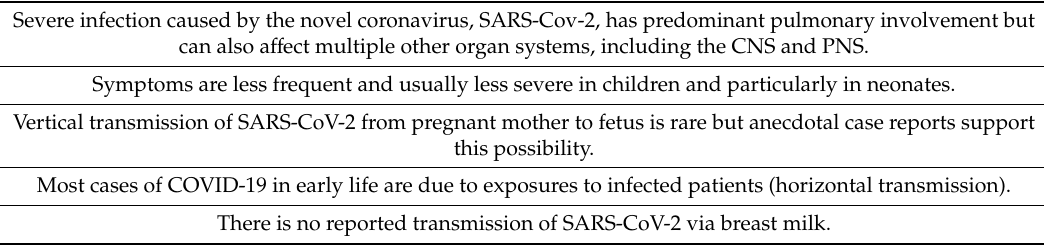
Table 4. Summary of COVID-19 infections in children.